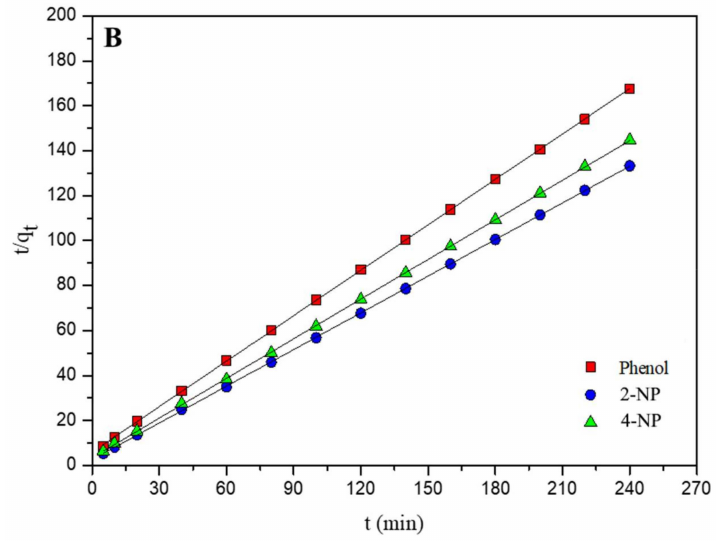
Figure 6. PFO ( A ) and PSO ( B ) kinetic plots for the removal of phenol, 2-NP, and 4-NP by DKLAAC